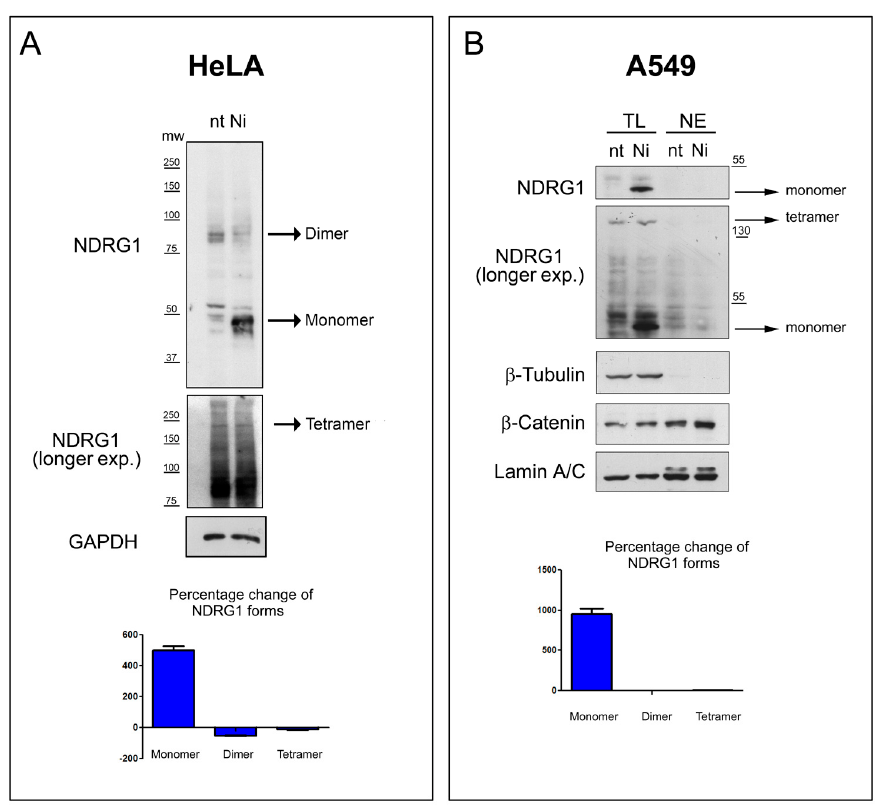
Figure 11. Nickel exposure promotes the expression of the monomeric form of h NDRG1. ( A ) HeLa cells were treated with 1 mM NiSO 4 for 24 h or left untreated (nt) and lysed under nondenaturing conditions, and lysates were then resolved by an SDS-PAGE under nondenaturing conditions. Corresponding filters were incubated with an antibody against the N-terminal region of NDRG1. GAPDH was used as equal loading marker. Histogram indicates the fold variation of the indicated forms of NDRG1 after nickel exposure compared to the untreated counterparts. ( B ) Lung carcinoma-derived A549 cells were treated with 1 mM NiSO 4 for two days (Ni) or left untreated (nt). Total lysates (TL) and nuclear extracts (NE) were analyzed in SDS-PAGE and the amount of NDRG1 was evaluated by Western blot analysis. β -tubulin and lamin A/C indicated the purity of nuclear extraction and equal loading. Histogram indicates the fold variation of the indicated forms of h NDRG1 after nickel exposure compared to the untreated counterparts. Western blots represent the most representative images of four repetitions of the same experiment.